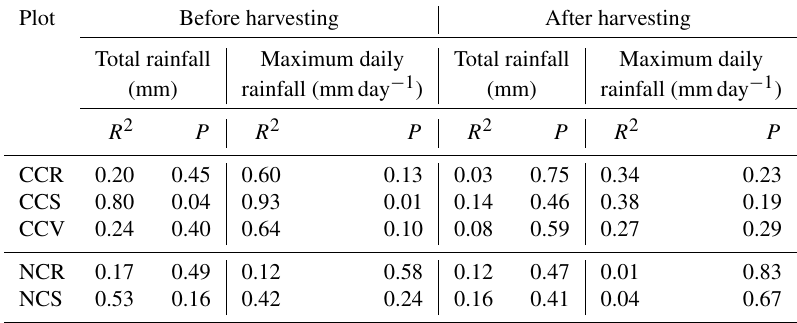
Table 5. R -squared and p -values of linear regressions between sediment weight captured by sediment traps and rainfall factors in rainfall seasons. Plot Before harvesting After